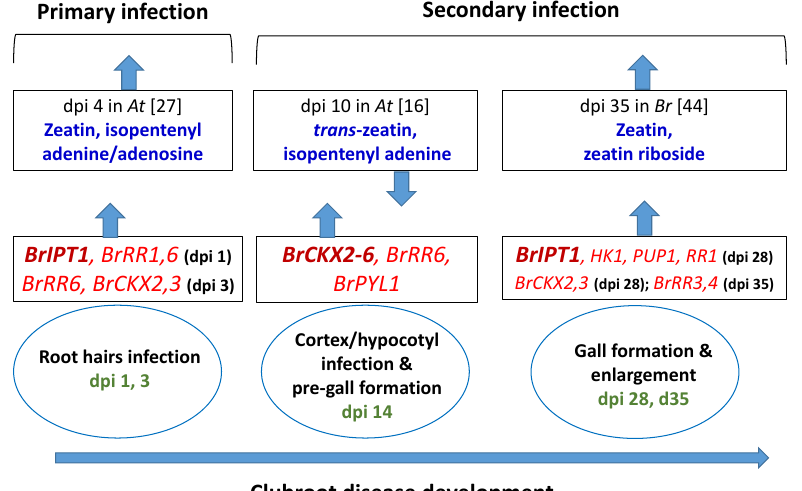
Figure 8. Association between relative expressions of cytokinin biosynthesis, response regulating and degrading genes in this study (red color) and published cytokinin contents at the closer time-points in Arabidopsis thaliana and Brassica rapa (blue color). dpi, days post inoculation. Green color represents dpi at which samples were collected. Upwards- and downwards-pointing arrows represent upregulation / increase and downregulation / decrease of genes / cytokinin contents, respectively, in clubroot infected plants compared to non-infected